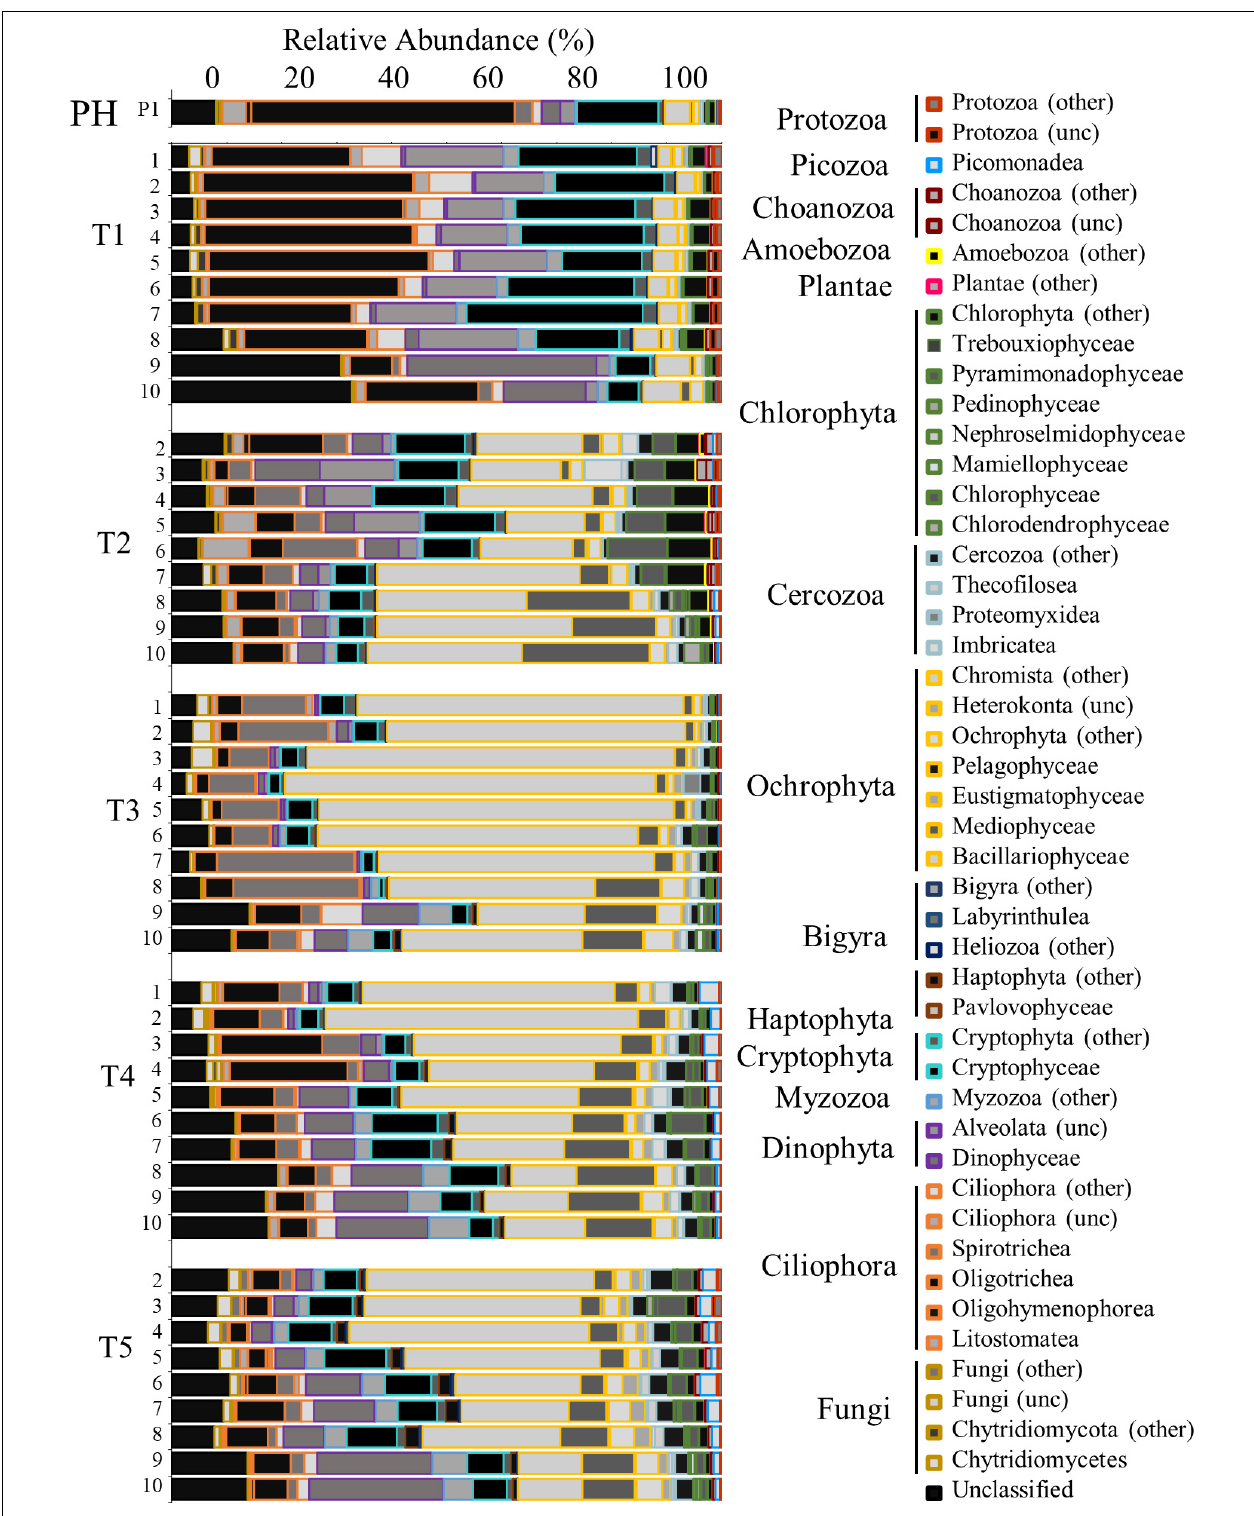
FIGURE 7 | Bar graph showing the relative abundance of OTUs for the eukaryotic community identified by 18s rRNA analysis. Time points are separated into blocks (T1–T5). Within each time point block, each bar represents the relative abundance for the members of the bacteria community at each station (1–10). The phyla are indicated by differing border color on the bar graphs [unclassified (unc)]. P1 is a pre-Harvey sample from 07/31/17.